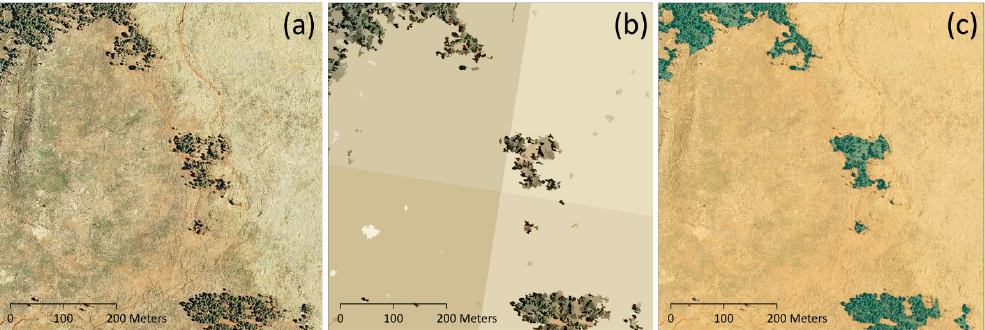
Figure 2. Image processing and classification flow, as follows: ( a ) 1-m resolution post-fire NAIP image, ( b ) object-based result of image segmentation, and ( c ) final classified product (transparent map displayed over original source image).